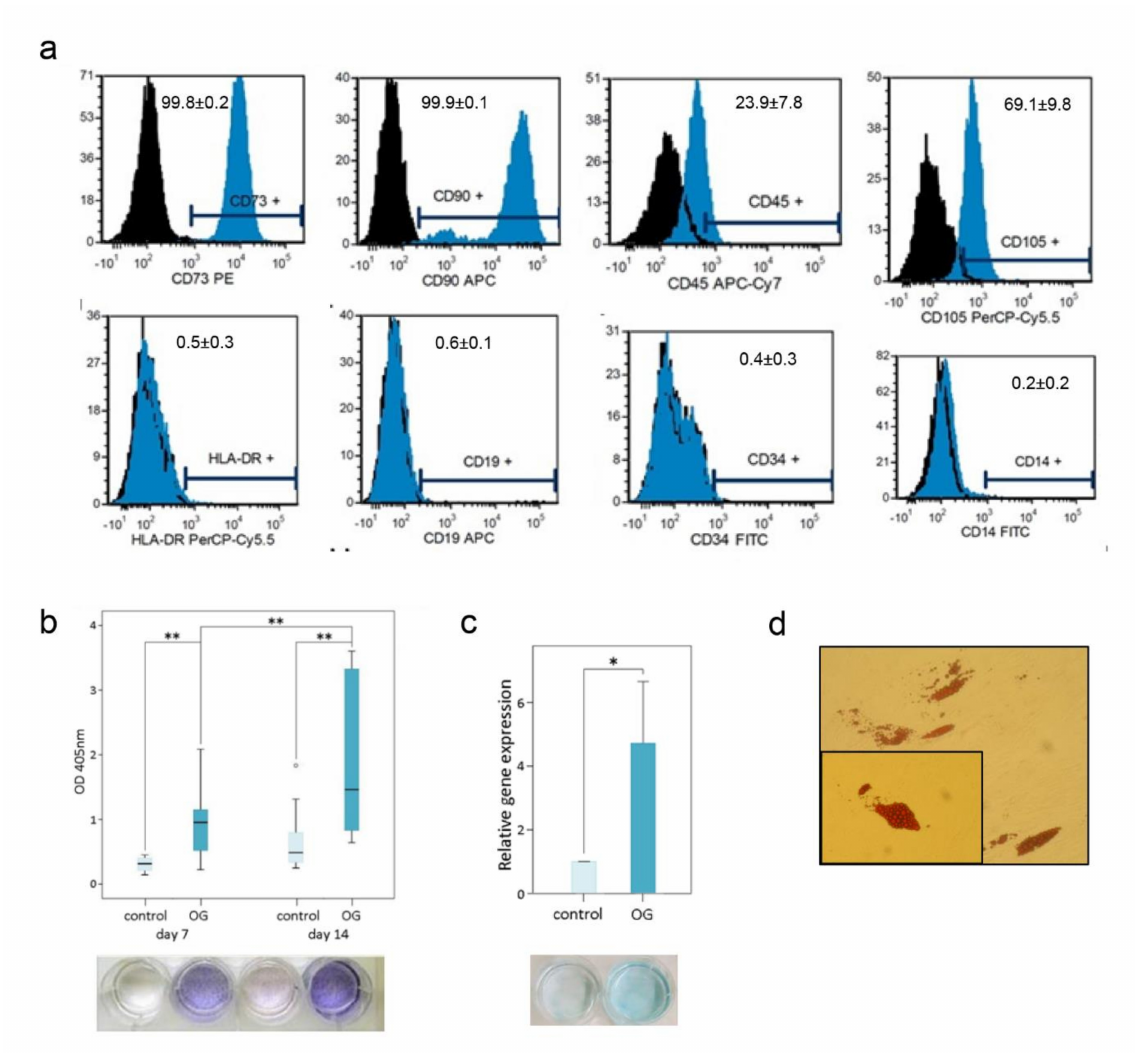
Figure 2. Multilineage differentiation analysis and flow cytometry surface characterisation of mesenchymal stem and progenitor cells (MSPCs). The isolated MSPCs were characterised according to ( a ) the positive expression of CD73, CD90, CD105 and the negative expression of CD14, CD19, CD34, CD45 and HLA-DR by flow cytometry (black: unstained cells; blue: stained cells). The differentiation potential was clearly demonstrated by ( b ) alkaline phosphatase (ALPL), osteocalcin and osteopontin expression for osteogenic differentiation, ( c ) Alcian blue staining and the expression of aggrecan for chondrogenic differentiation and ( d ) Oil Red O staining of lipid droplets for the adipogenic lineage. Statistical significances are defined as follows: ** p < 0.01; * p <